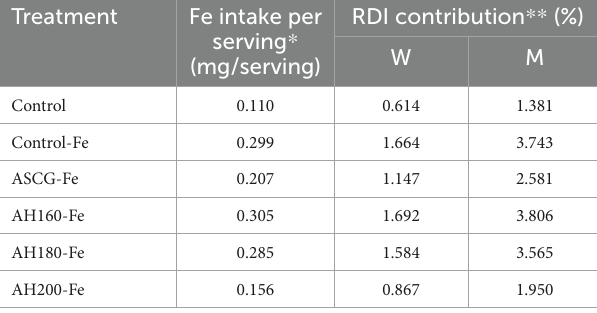
TABLE 4 Nutritional dietary contribution of Fe of lettuces.